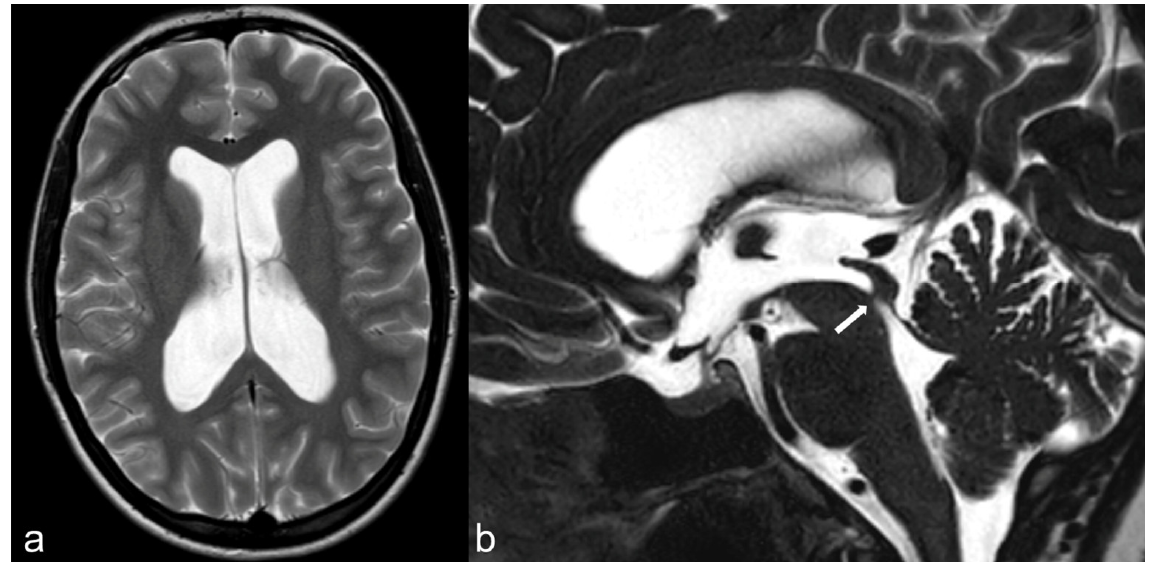
Figure 7. 26-year-old female patient presenting with long-standing headache, unresponsive to medical therapy. MRI reveals obstructive supratentorial hydrocephalus. ( a ) Axial T2-weighted (T2-w.) turbo spin echo (TSE) image shows enlargement of the lateral ventricles. No signs of transependymal edema are apparent. ( b ). 3D CISS depicts a subtle hypointense membrane (arrow) located at the level of the cerebral aqueduct. Findings are consistent with aqueductal web. The patient subsequently underwent endoscopic third ventriculostomy.